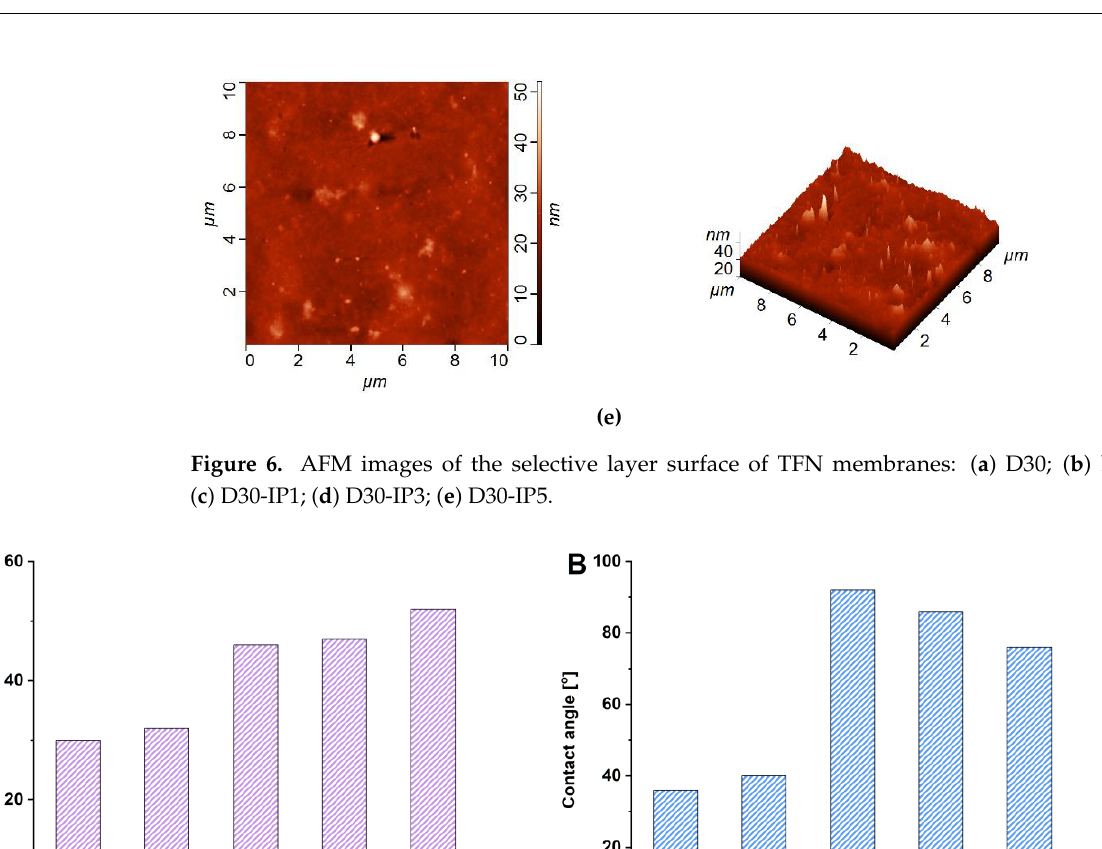
Figure 6. AFM images of the selective layer surface of TFN membranes: ( a ) D30; ( b ) D30-IP; ( c ) D30- IP1; ( d ) D30-IP3; ( e ) D30-IP5.